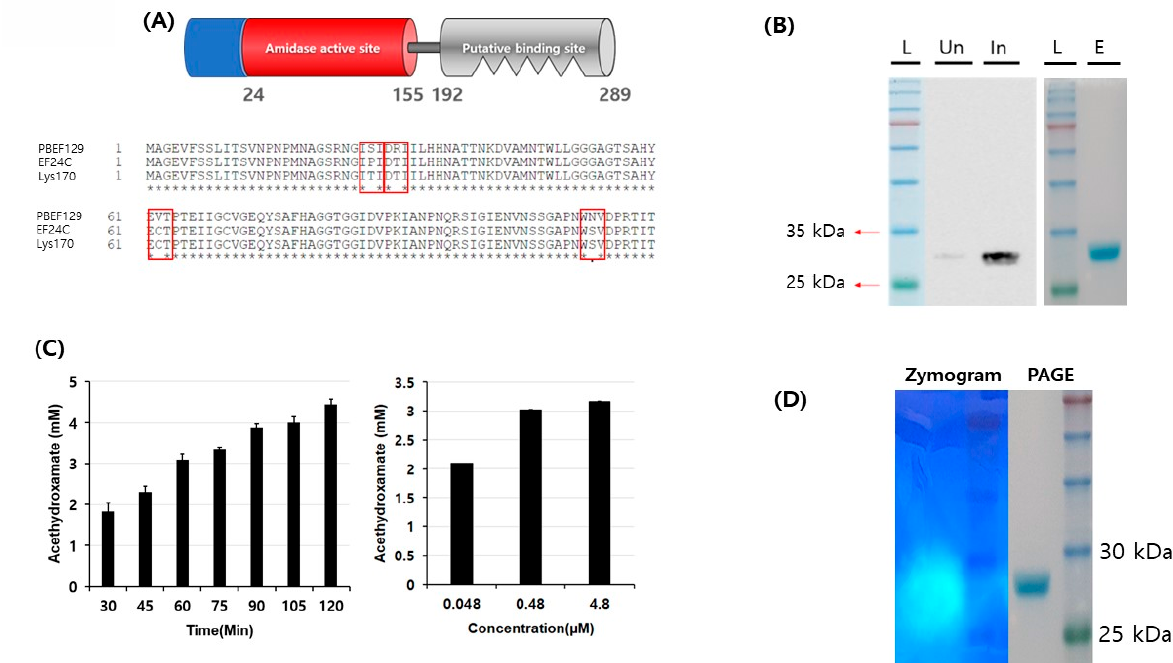
Figure 2. Purification and enzymatic activity of endolysin. ( A ) Suggested domain structure of the endolysin of phage PBEF129 from BLAST domain search. The total length of the endolysin is 289 amino acids. The putative amidase active domain (red) is from 24 to 155 amino acids and the putative peptidoglycan binding domain (gray) is 192 to 289 amino acids. Amino acids’ sequence alignment among related endolysins, PBEF129, EF24C and Lys170 [17], is seen under the domain diagram. Different amino acid residues in sequences are shown in the box. Only four amino acid residues differ in the enzymatically active domain (EAD). ( B ) Purification of the recombinant endolysin. Right panel, purification of putative endolysin. L, pre-stained protein ladder; E, eluted fraction. Left panel, Western blot analysis of the purified protein using anti-6XHis antibody. L, pre-stained protein ladder; Un, un-induced culture lysate; In, induced culture lysate. ( C ) Left: confirmation of amidase activity of the purified protein with various incubation times; 4.8 μ M of protein was used for each time point. Right: confirmation of amidase activity of the purified protein with various amounts of protein. One-hour incubation was used for each enzyme concentration. ( D ) Left: zymogram of purified endolysin run on a non-denaturing PAGE containing the target bacteria. Right: PAGE analysis of the endolysin followed by Coomassie Brilliant Blue staining.